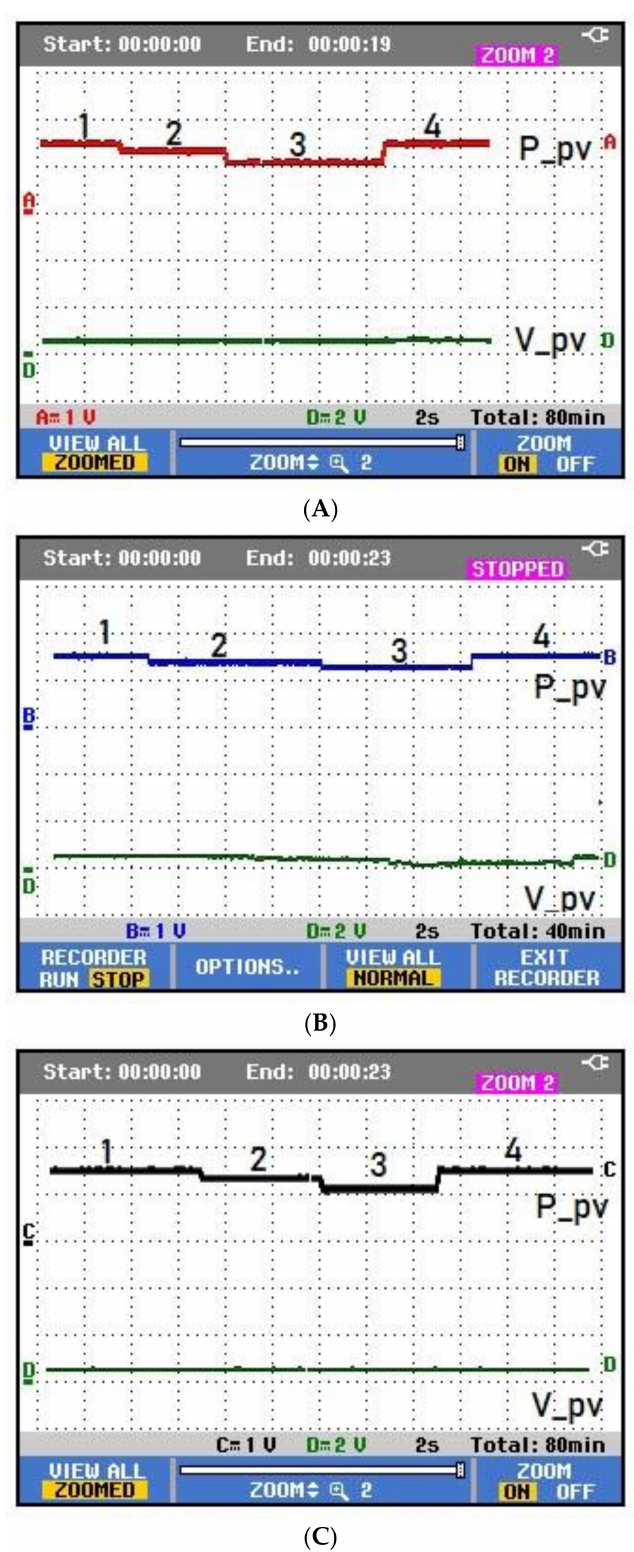
Figure 26. ( A ) Output power and voltage with MDOF-FLC under varying temperature levels and constant radiation (1000 Watt/m 2 ). ( B ) Output power and voltage with SUIPID under varying temperature levels and constant radiation (1000 Watt/m 2 ). ( C ) Output power and voltage with FLC under varying temperature levels and constant radiation (1000 Watt/m 2